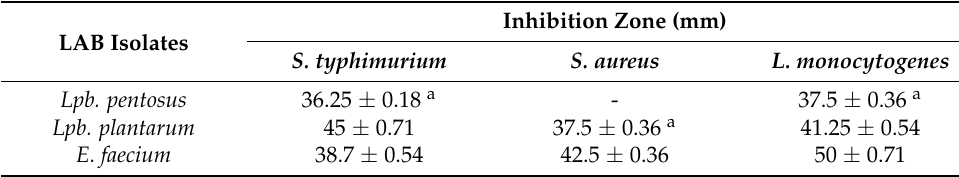
Table 2. Antimicrobial activity of LAB